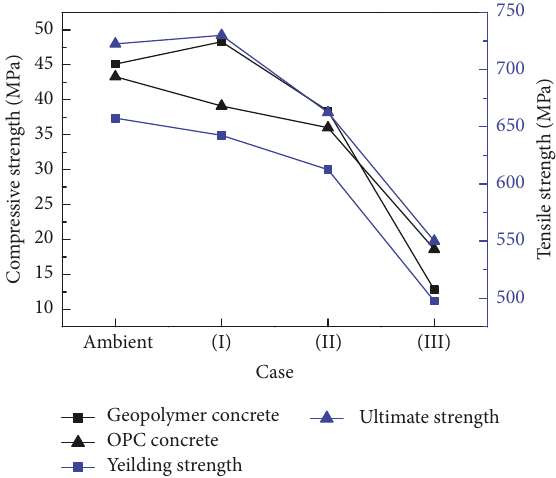
Figure 6: Strength of reserved concrete and